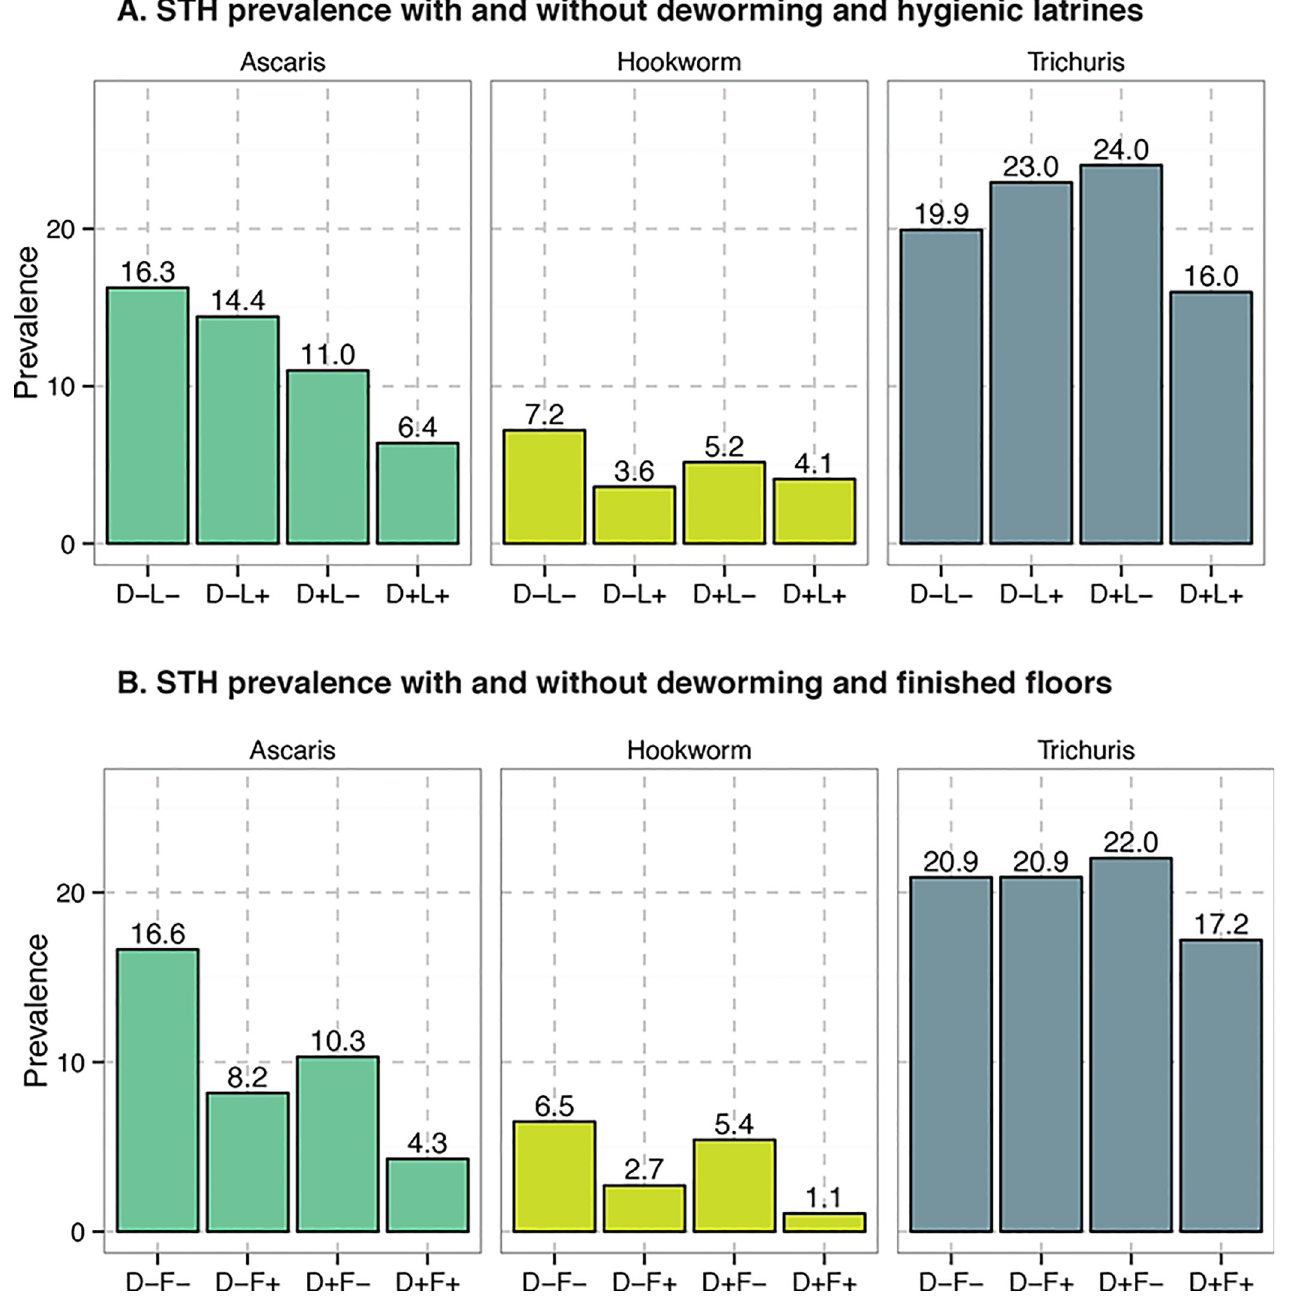
Fig 3. STH prevalence by exposure to deworming, hygienic latrines, and finished floors. Panel A shows the prevalence of each helminth among those who did not receive deworming (D-), those who did receive deworming (D+), those who did not have access to a hygienic latrine (L-), and those who did have access to a hygienic latrine (L+). Panel B shows the prevalence of each helminth among those who did not receive deworming (D-), those who did receive deworming (D+), those whose household did not have a finished floor (F-), and those whose household did have a finished floor (F+).